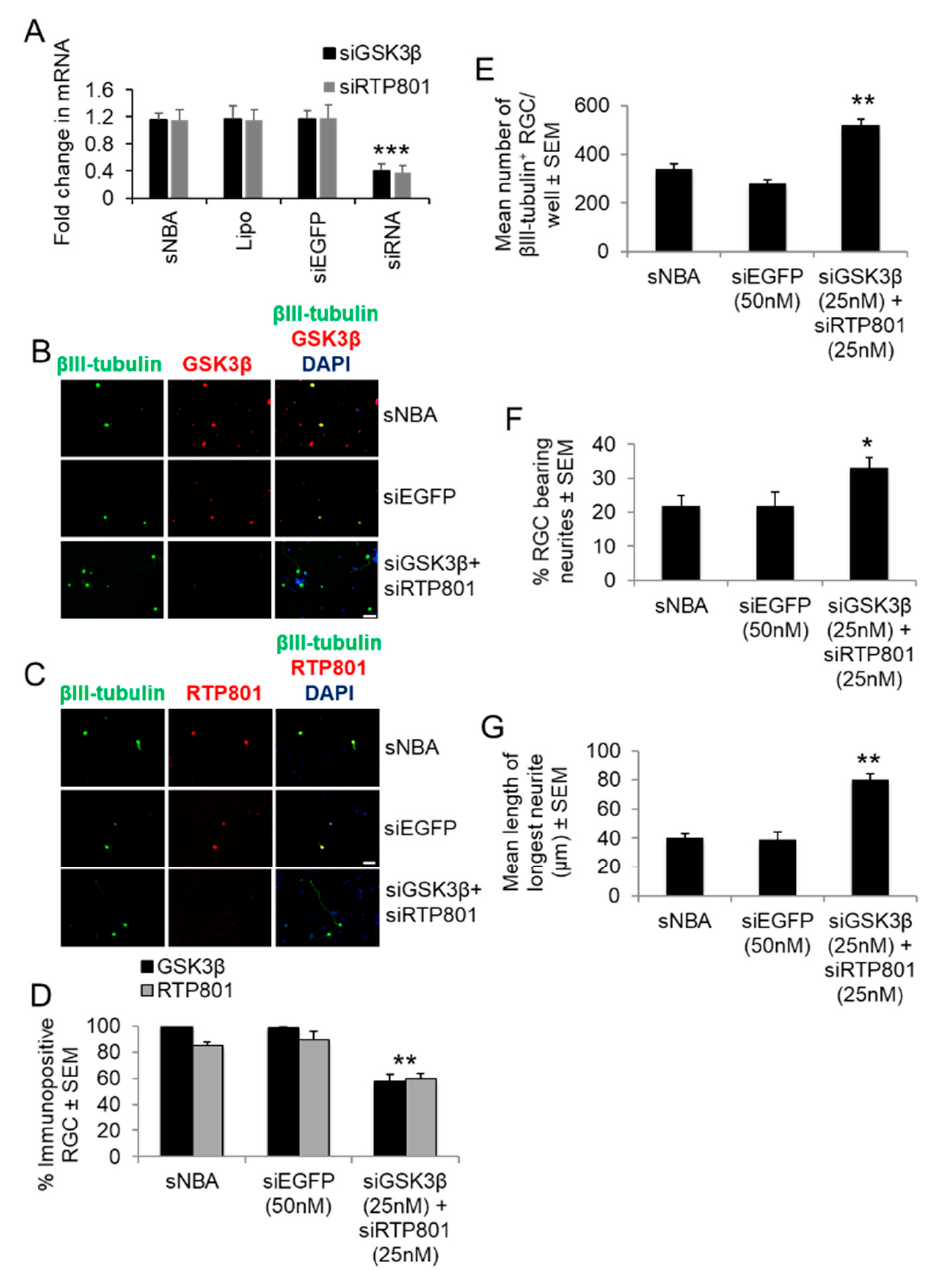
Figure 8. The e ff ect of combined siGSK3 β + siRTP801 on GSK3 β and RTP801 immunoreactivity in Figure 8. The effect of combined siGSK3 β + siRTP801 on GSK3 β and RTP801 immunoreactivity in